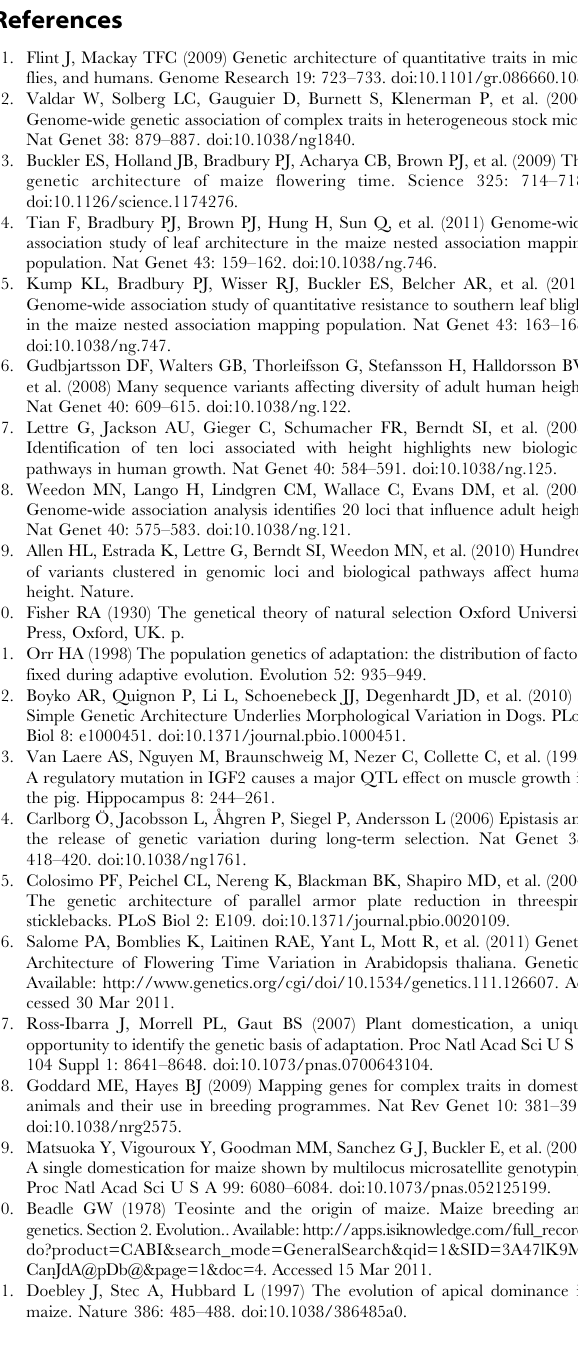
Table S1 Joint Linkage QTL. Table S2 GWAS SNPs. Table S3 Pleiotropy in joint linkage analysis. Table S4 Pleiotropy in GWAS